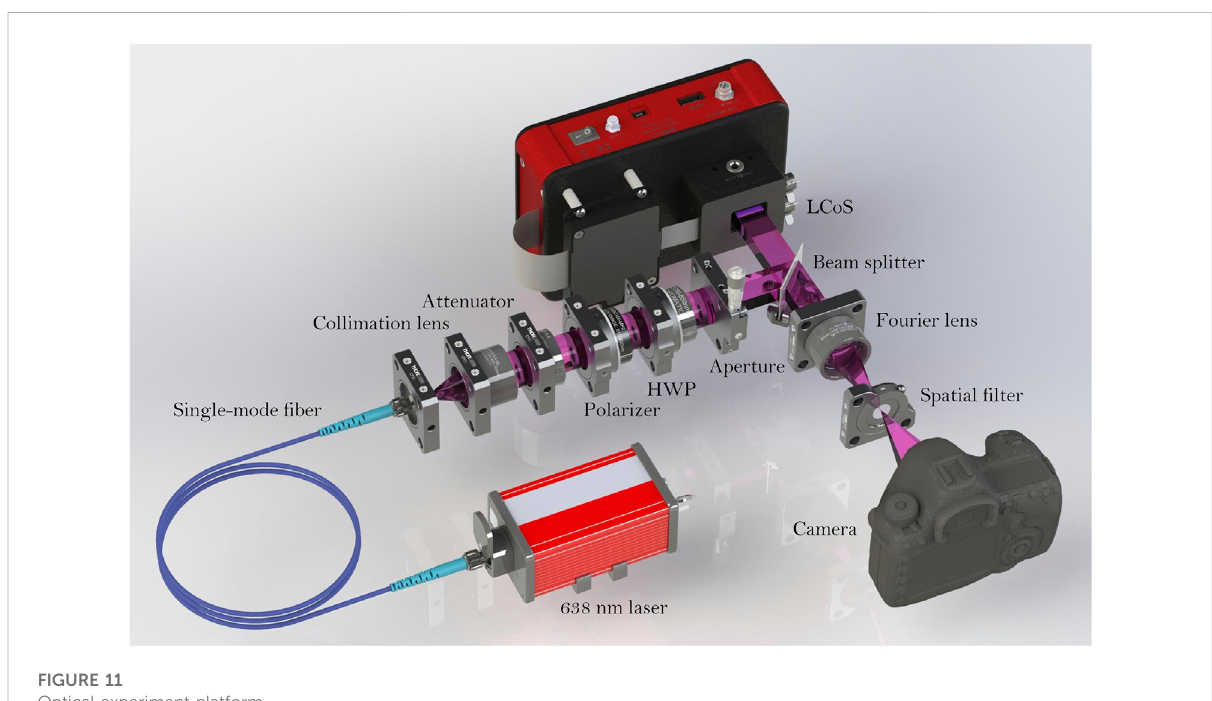
FIGURE 11 Optical experiment